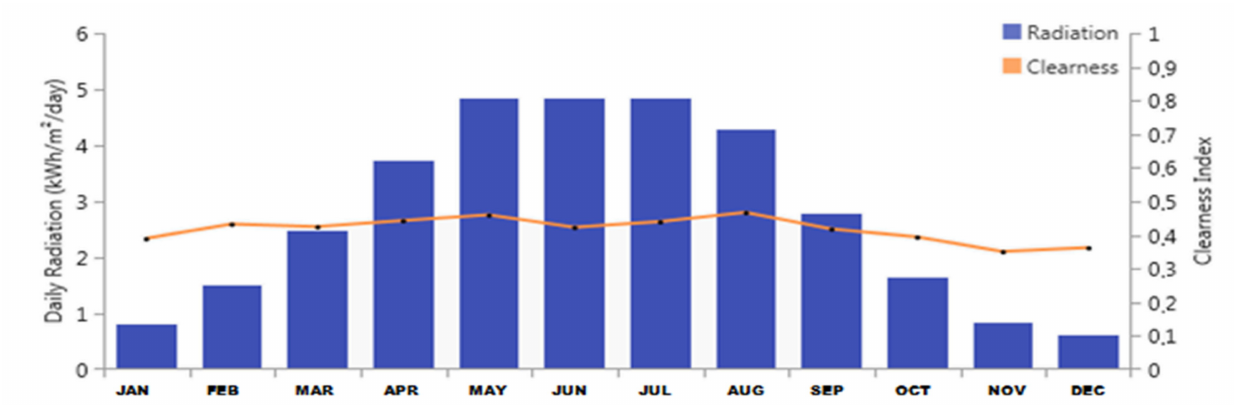
Figure 6. Annual average radiation (kWh/m2/day) in the Lubuskie Voivodeship. Source: own study using Homer Grid software.